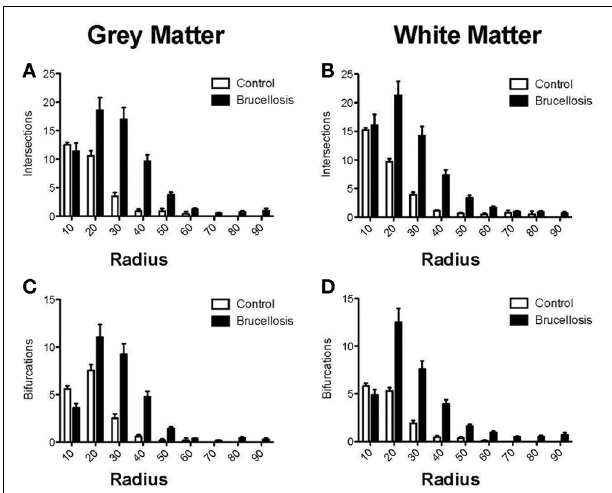
FIGURE 5 | Astrocytes have increased complexity following Brucella infection. In both gray and white matter astrocytes there was an increase in the number of intersections from 20 μ m onwards ( A, B , respectively). This was borne out by the increased number of bifurcations in the astrocyte processes (C, D) leading to increased complexity of the